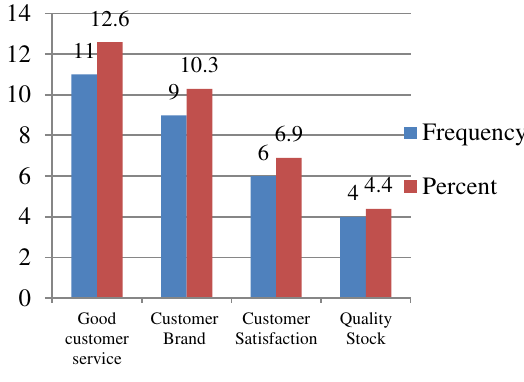
Fig. 9. Respondents about customer ‘s perception towards Fig. 7. Respondent’s perception can drive the automotive product quality in you business? business to become successful It is evident that, with 11 (12.6 percent) of Figure 7 indicates that the majority of respondents 34 respondents indicating their ability to get good (39.1 percent) agreed that the customer’s perception customer service, this is the factor that has can drive automotive business to become successful. encouraged them to keep buying the product. A total of 9 (10.3 percent) of respondents showed that customer brand is good for the business, neutral, while 4 (4.6) strongly disagreed and 3 (3.4 while 6 (6.9 percent) of respondents showed that customer satisfaction is good and 4 (4.04 percent) showed that the customers are willing to buy quality